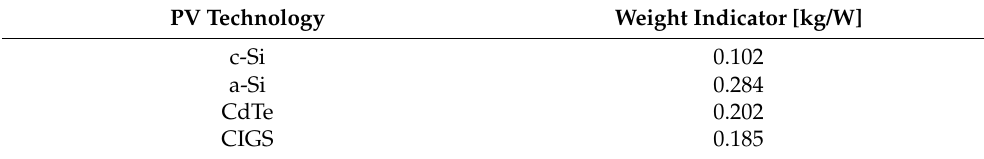
Table 4. Weight indicators for photovoltaic module technologies.